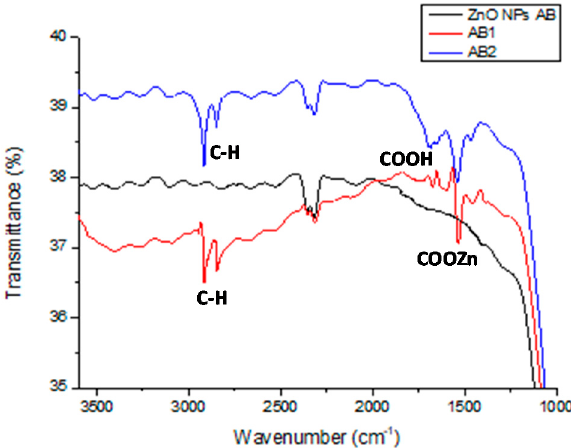
Figure 3. Fourier-transform infrared (FT-IR) spectra on CaF 2 substrates of the ZnONPs layer deposed by airbrushing (black trace), ZnO NPs/stearic acid AB1 (red trace) and AB2 (blue trace) coatings.